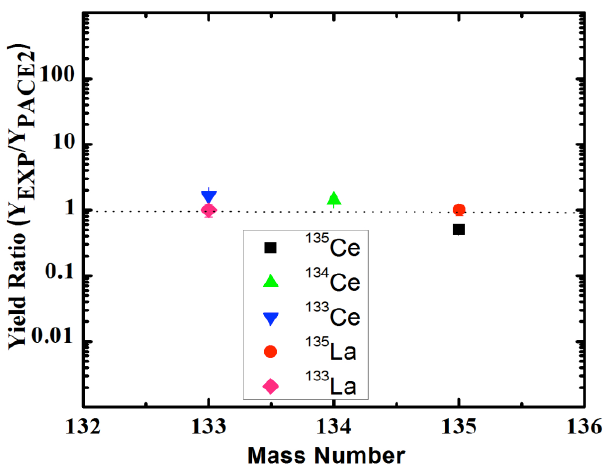
Figure 3. (Colour online) The ratio of experimentally measured and theoretically estimated relative production yields of the residues populated via CF in xn and pxn channels for the system 16 O+ 124 Sn at 100 MeV